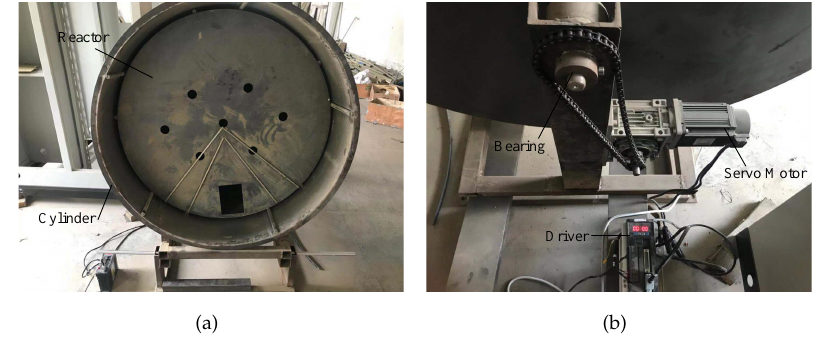
Figure 3. Experimental model. ( a ) front of the model; ( b ) back of the